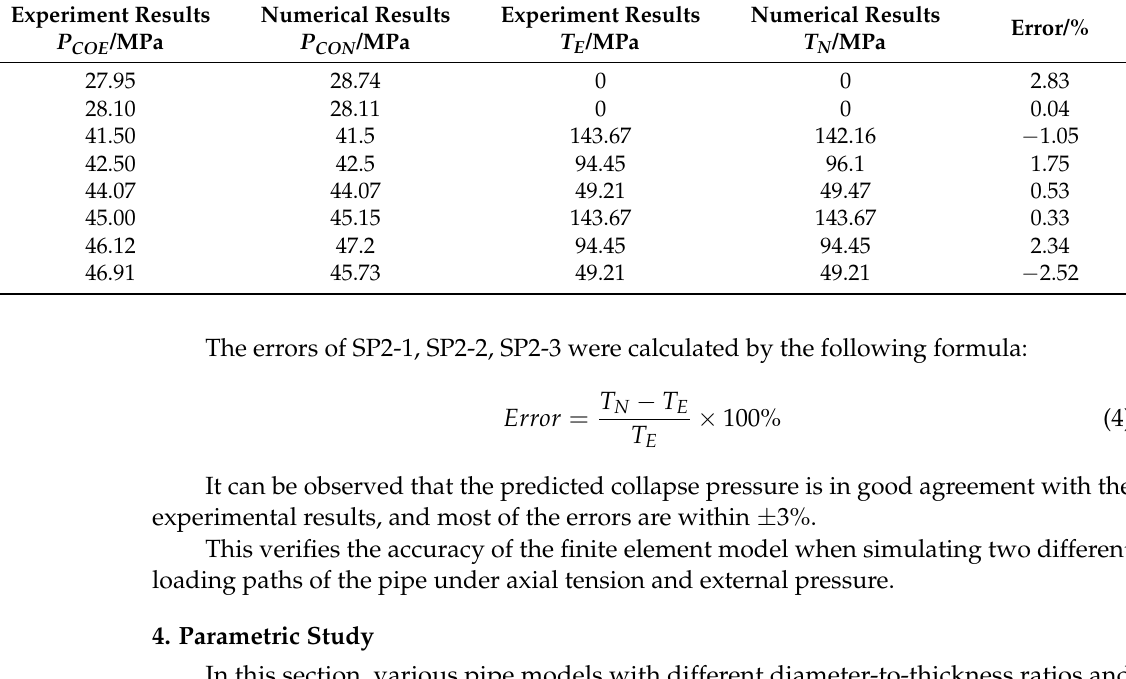
Table 6. Overview of geometry parameters and collapse pressure of all tested specimens. Pipe